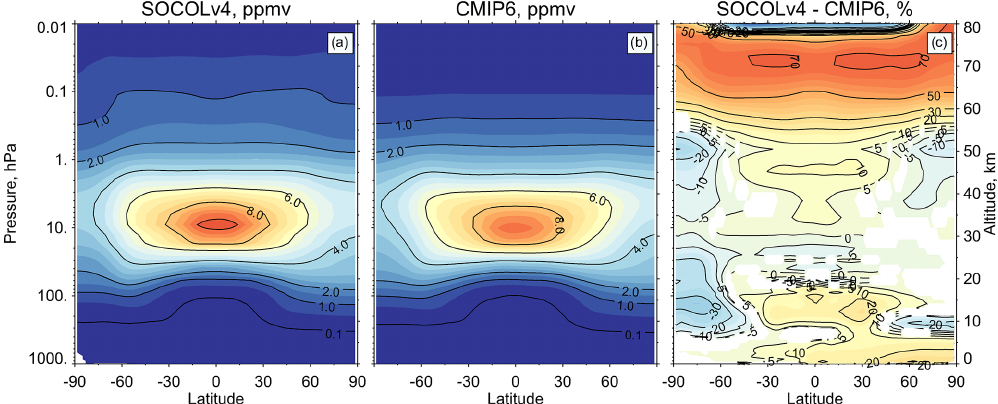
Figure A3. Ozone zonal and annual mean climatology (1985–2012) calculated by (a) the SOCOLv4 model (ppmv) and (b) provided by the CMIP6 modeling composite. The relative differences between SOCOLv4 and CMIP6 are shown in panel (c) . White areas are either missing data or regions where the difference between model and observations is not statistically significant at the 95% confidence